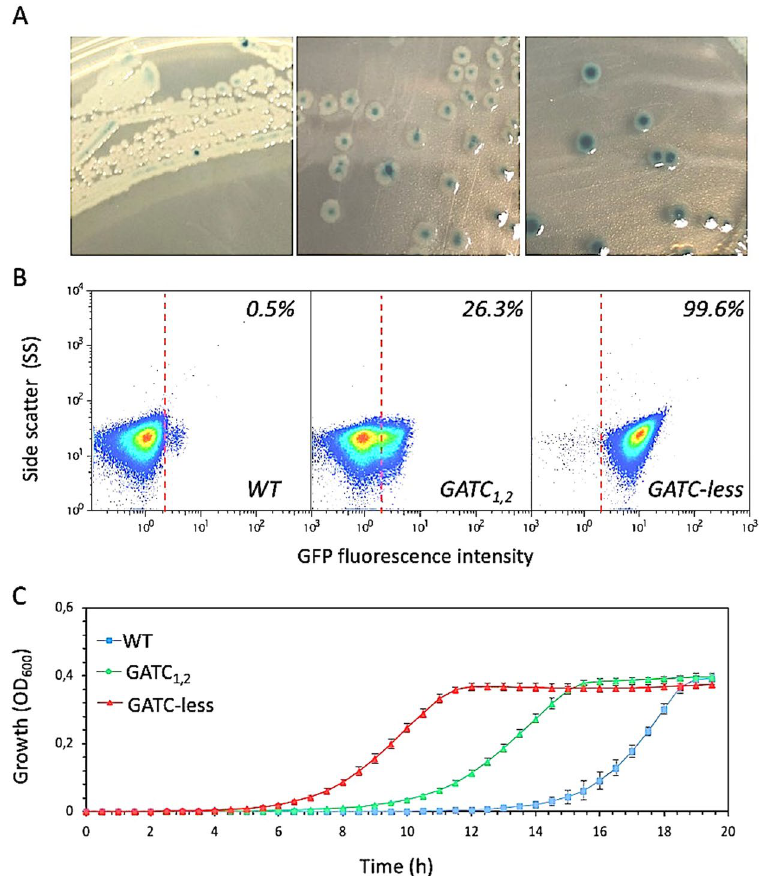
Figure 2. Formation of Lac OFF and Lac ON subpopulations under opvAB control in E . coli . ( A ) Left: Colonies formed on LB + X-gal by an E . coli strain carrying the lacZY operon under the control of the wild type opvAB control region (strain DR22). Center and right: Colonies formed on LB + X-gal by E . coli strains carrying the lacZY operon under the control of mutant opvAB control regions (DR23 and DR24). ( B ) Flow cytometry analysis of P opvAB :: lacZY expression in strains DR22, DR23 and DR24. The sizes of Lac ON subpopulations are indicated. ( C ) Growth of strains DR22, DR23 and DR24 in NCE-lactose. Error bars represent the standard error of the mean from 3 independent